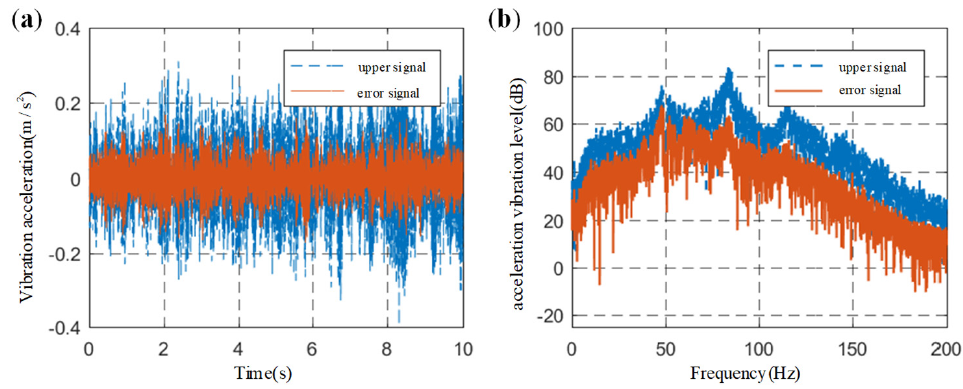
Figure 10. Experimental results of passive vibration isolation: ( a ) time history diagram; ( b ) acceleration vibration level.